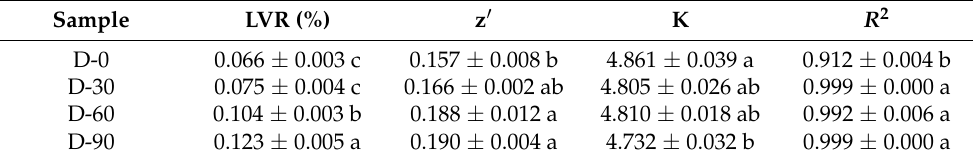
Table 3. Effect of proofing on the structure stability of CS–HPMC gluten-free